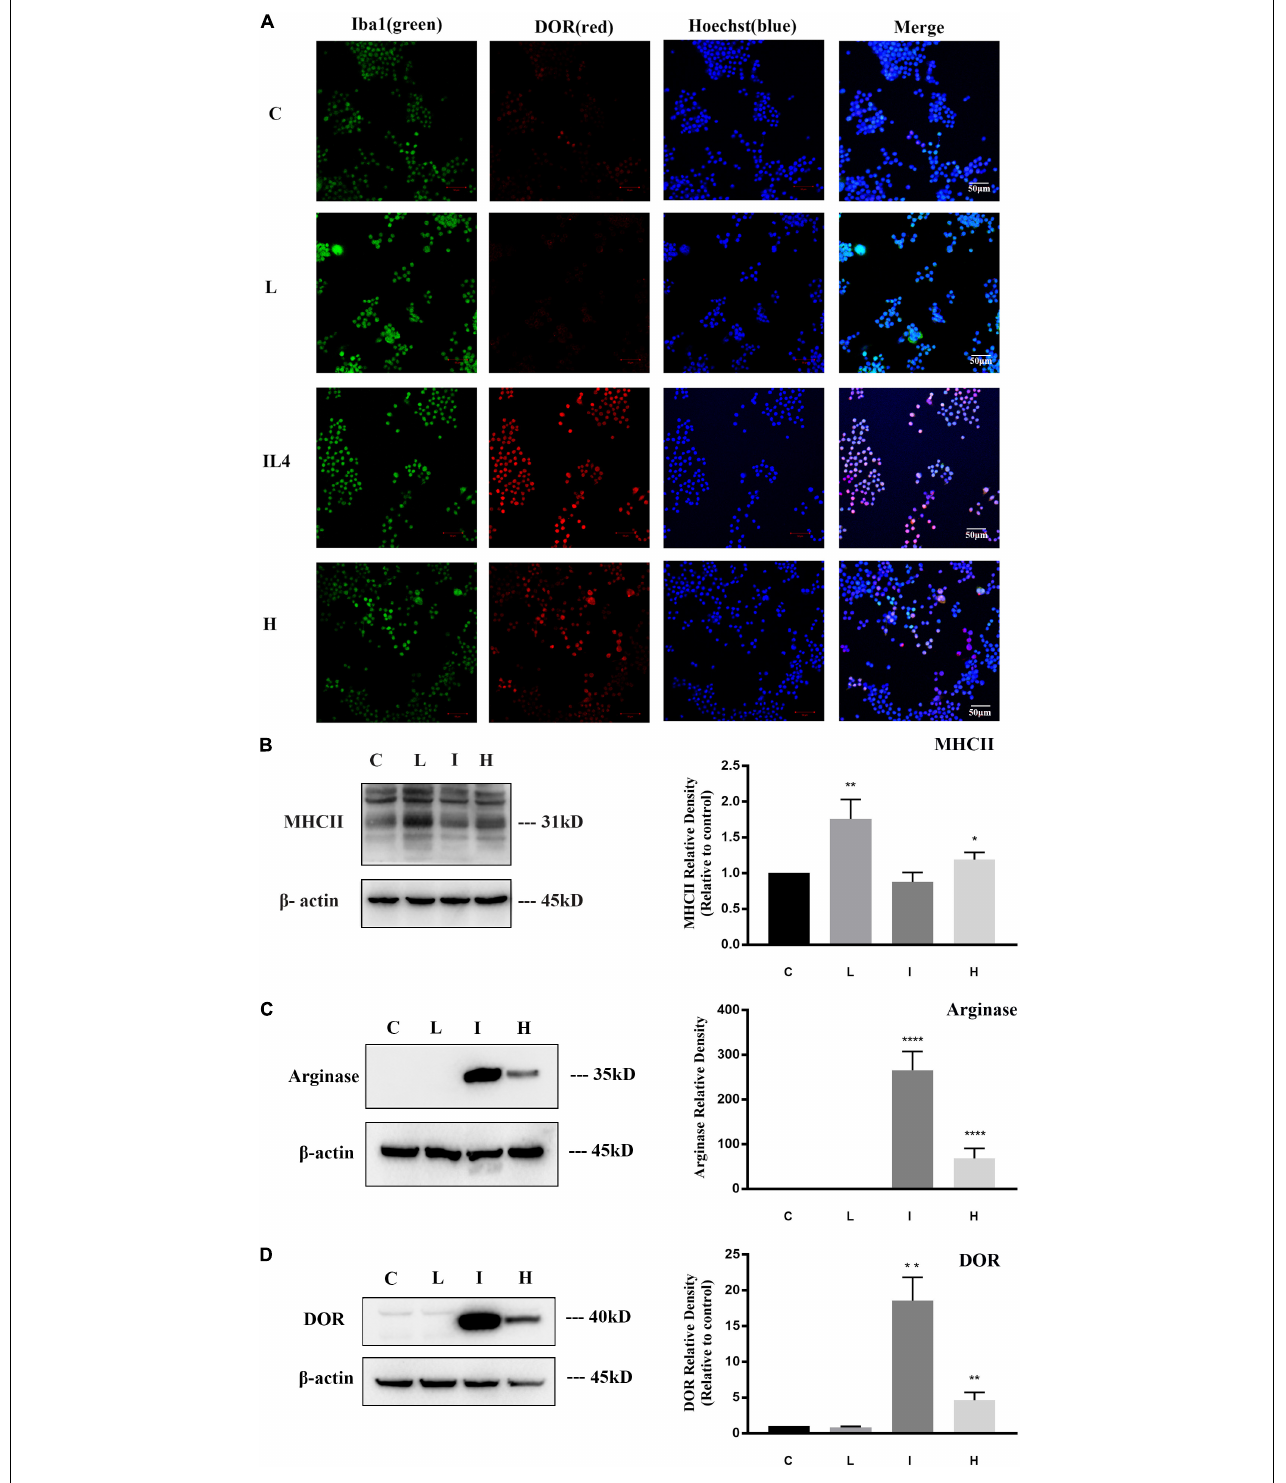
FIGURE 1 | δ -opioid receptor (DOR) expression and distribution in BV2 cells. The experiments were conducted on BV2 cells ( N = 3 in each group). C: normal control. L: LPS. I: IL4. H: 1% O 2 hypoxia. (A) Representative immunofluorescent images of BV2 cells exposed to normal, LPS, IL4, or hypoxic environment. The merge images merged Iba1 (green), DOR (red), and Hoechst (blue) images in each group. Note that the immunofluorescence staining showed that DOR maintained a mild expression level under normal condition and LPS insult, but the red fluorescence labeling DOR significantly enhanced after 24 h of IL4 treatments. Hypoxia induced both high-expressed DOR and low-expressed DOR BV2 cells. (B) Differential MHCII expression in BV2 cells under physiological, LPS, IL4, or hypoxic